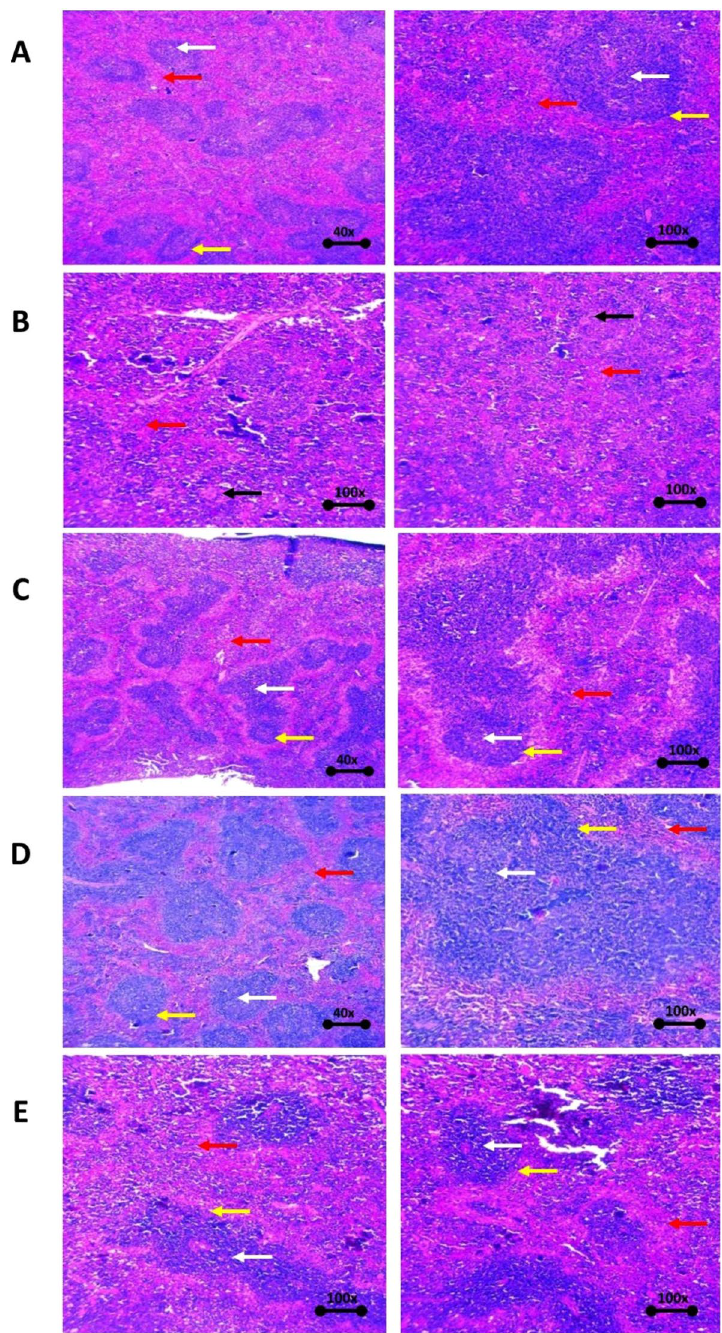
Figure 7. Histopathological picture of the spleen of mice ( A ) Normal, ( B ) Negative control induced with 25 mg NDEA/kgBW ip; ( C ) UA suspension, ( D ) Nio-UA, ( E ) Nio-UA-CS with an equivalent dose of 11 mg UA/kgBW with H&E staining. Red arrow = red pulp, white arrow = white pulp/germinal center, yellow arrow = marginal zone, black arrow = giant cell